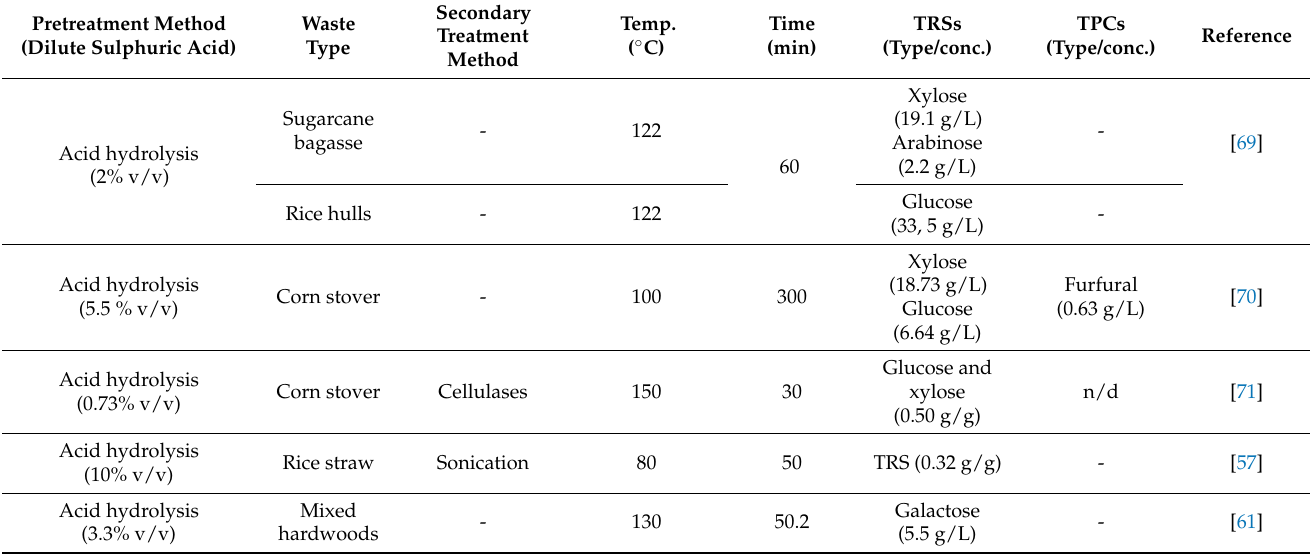
Table A3. Dilute sulphuric acid pretreatment of different lignocellulose wastes under different